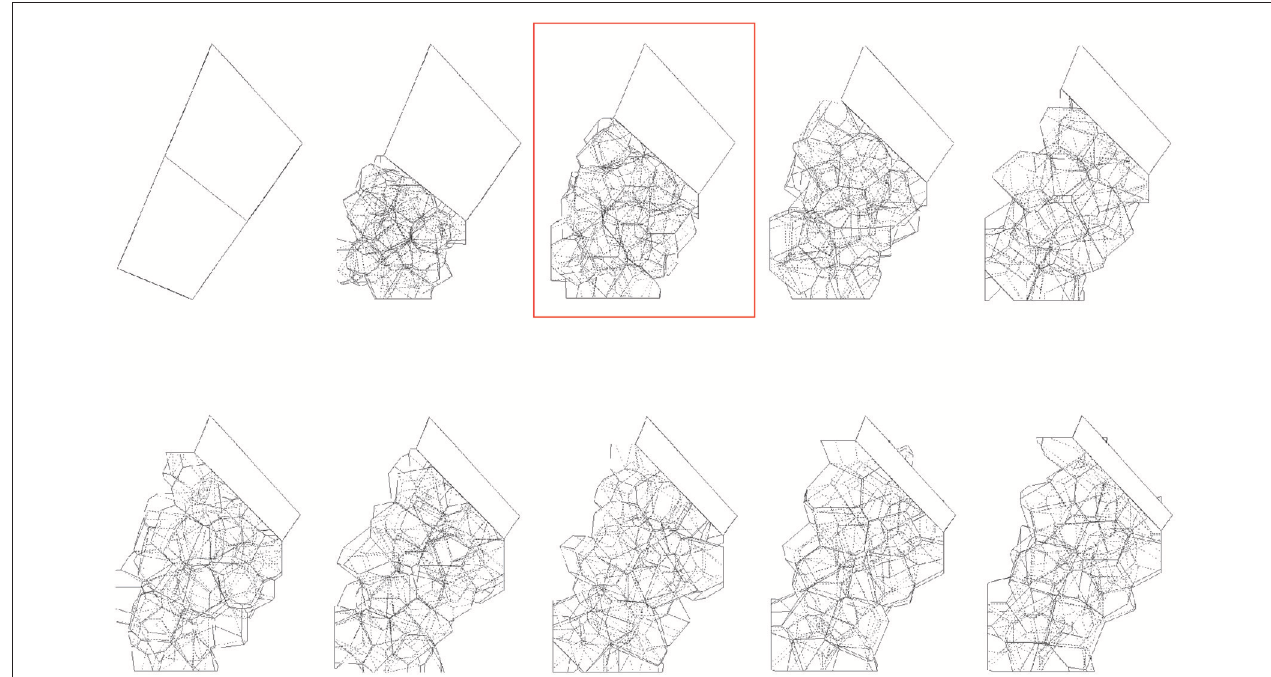
FIGURE 8 | The ten different subdivision values used to explore the result of different positions for the threshold curve (chosen alternative highlighted in red).